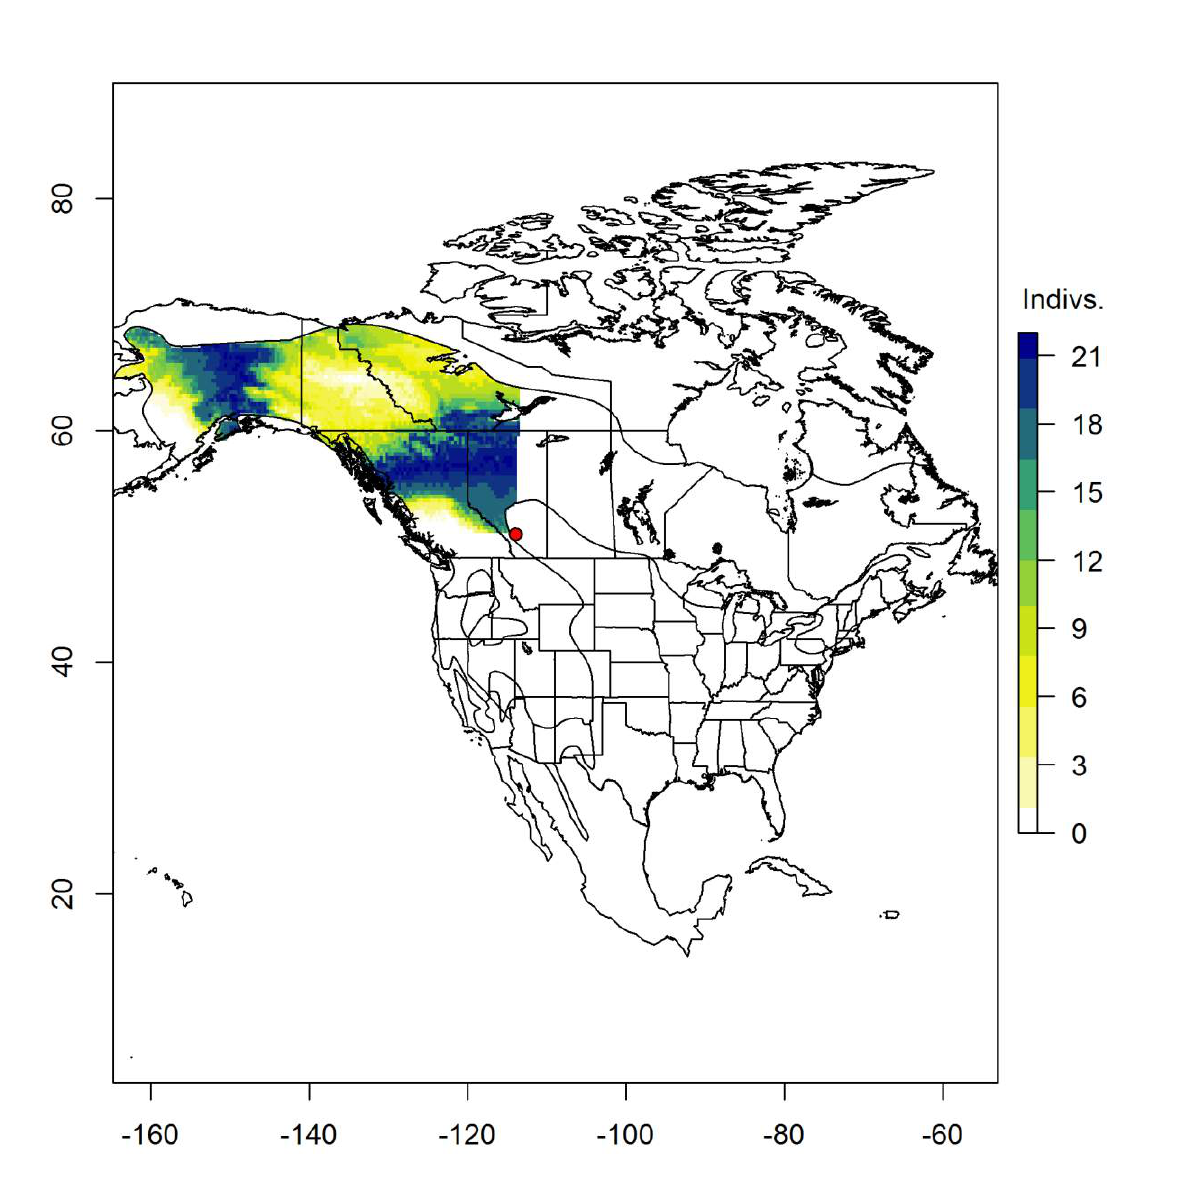
Figure A2.3: Probable origins of Swainson’s Thrush es ( Catharus ustulatus ) captured during fall migration at the IBS CMMN station in Southern Alberta